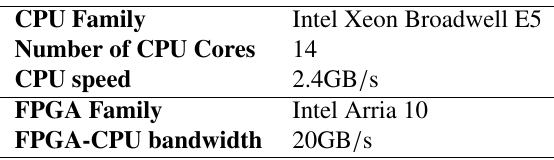
Table 1. Specifications for the Intel HARP v2 system [8].